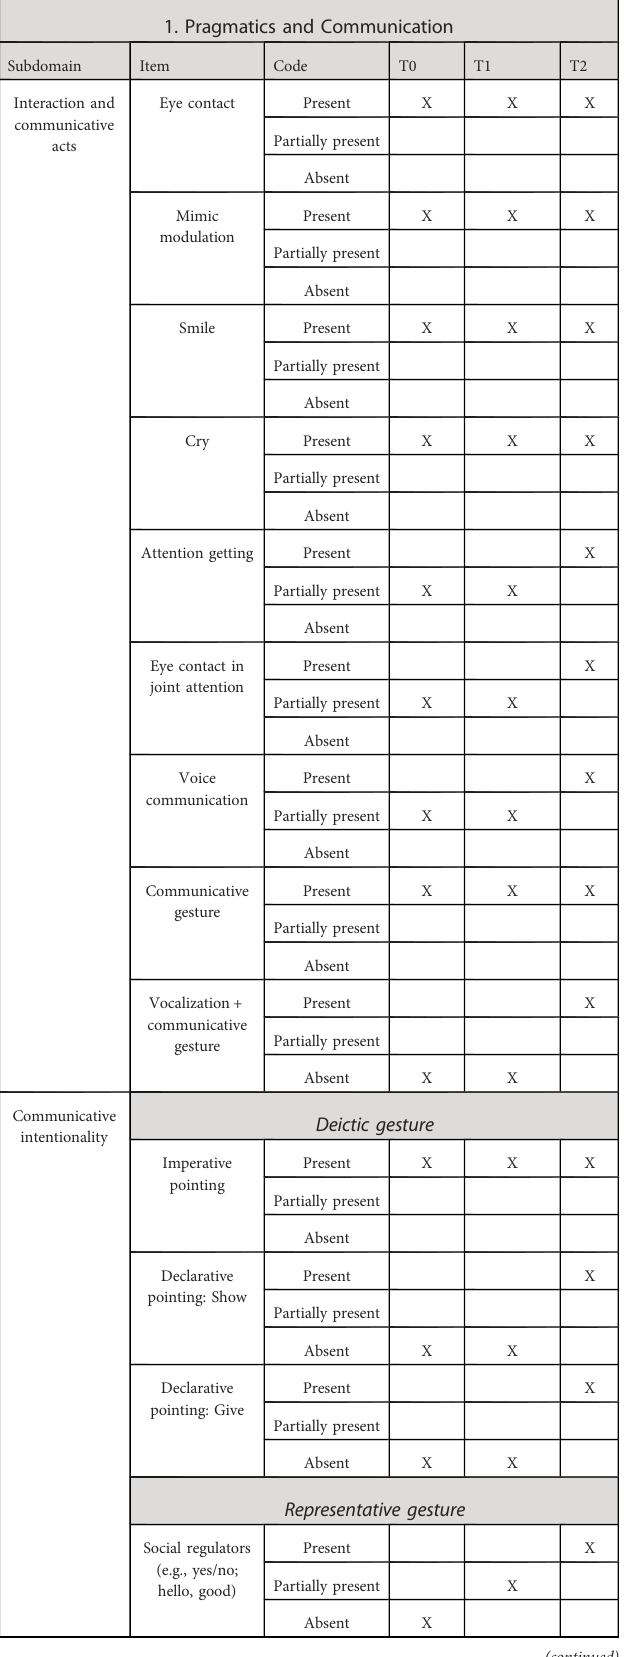
TABLE 2 Case #1 OPISCoS form: effects of the intervention at preintervention (T0), immediate postintervention (T1), and follow-up after 8 months